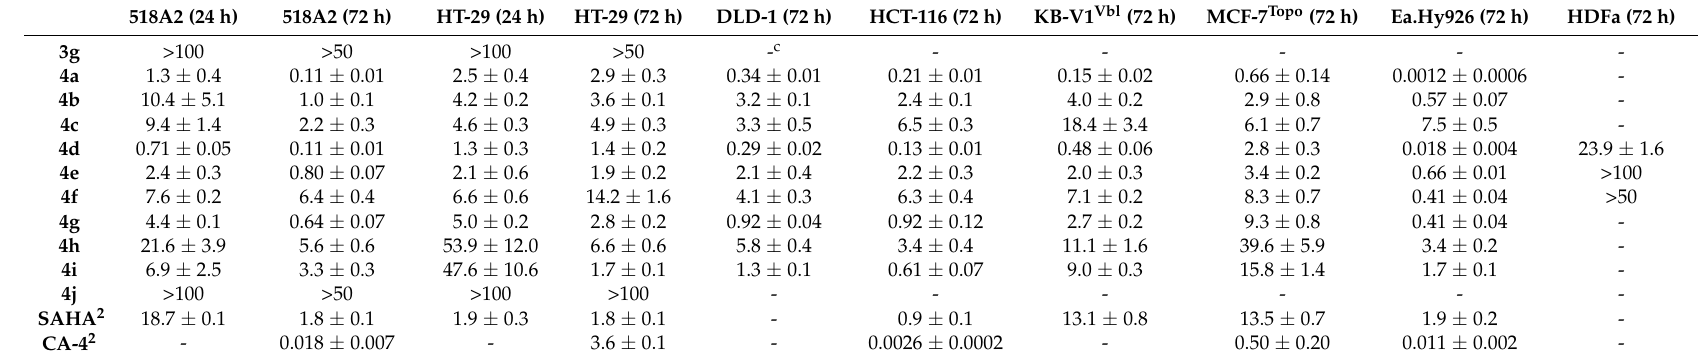
Table 1. Inhibitory concentrations IC 501 ( µ M) of 3g , 4a–j , SAHA, and CA-4 in cancer